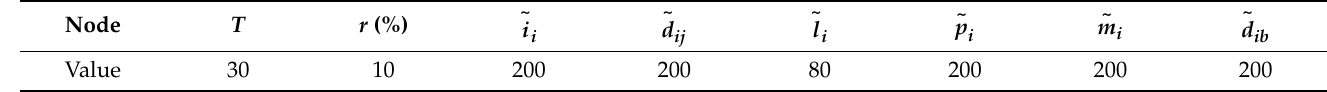
Table 8. Model parameters in Topology 1.